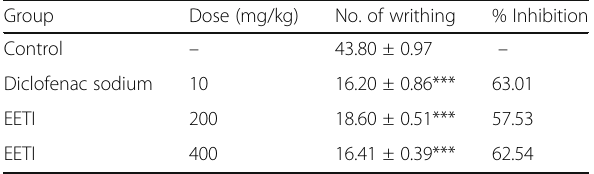
Table 1 Observation and results of phytochemical screening